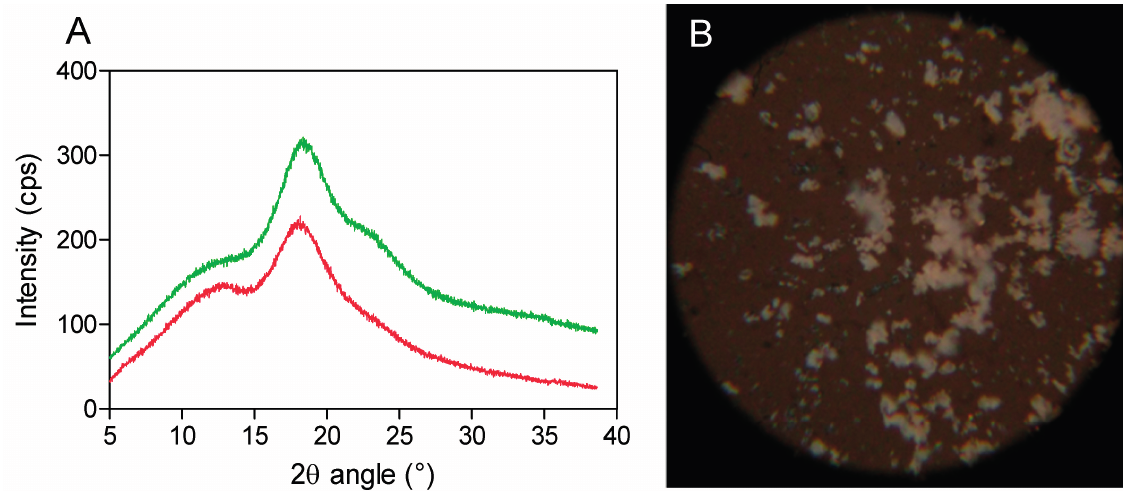
Figure 2. X-ray powder diffraction patterns ( A ) as red (SBE β CD) and green curves (SEV-SBE β CD) and polarized light microscopy ( B ) of the SEV-SBE β CD complex at 100× magnification. The beam intensity is measured in counts per second, abbreviated as